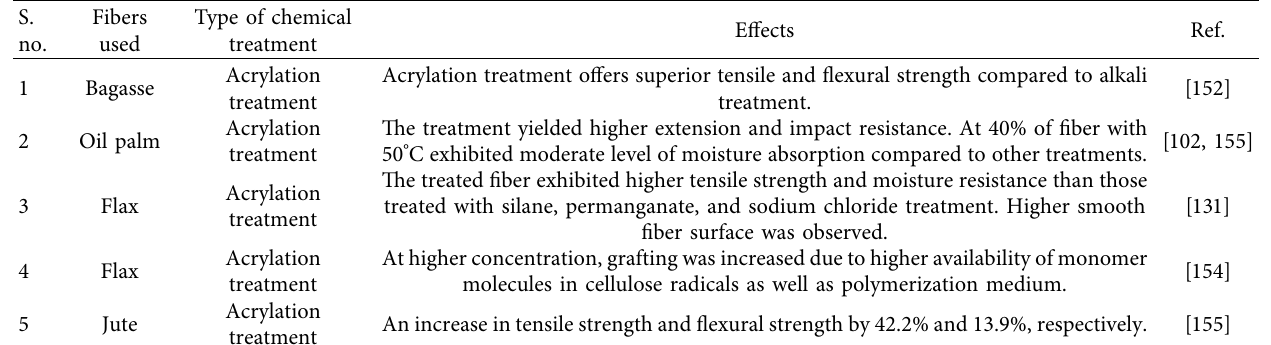
Table 7: Effect of acrylation treatment on various biofibers.